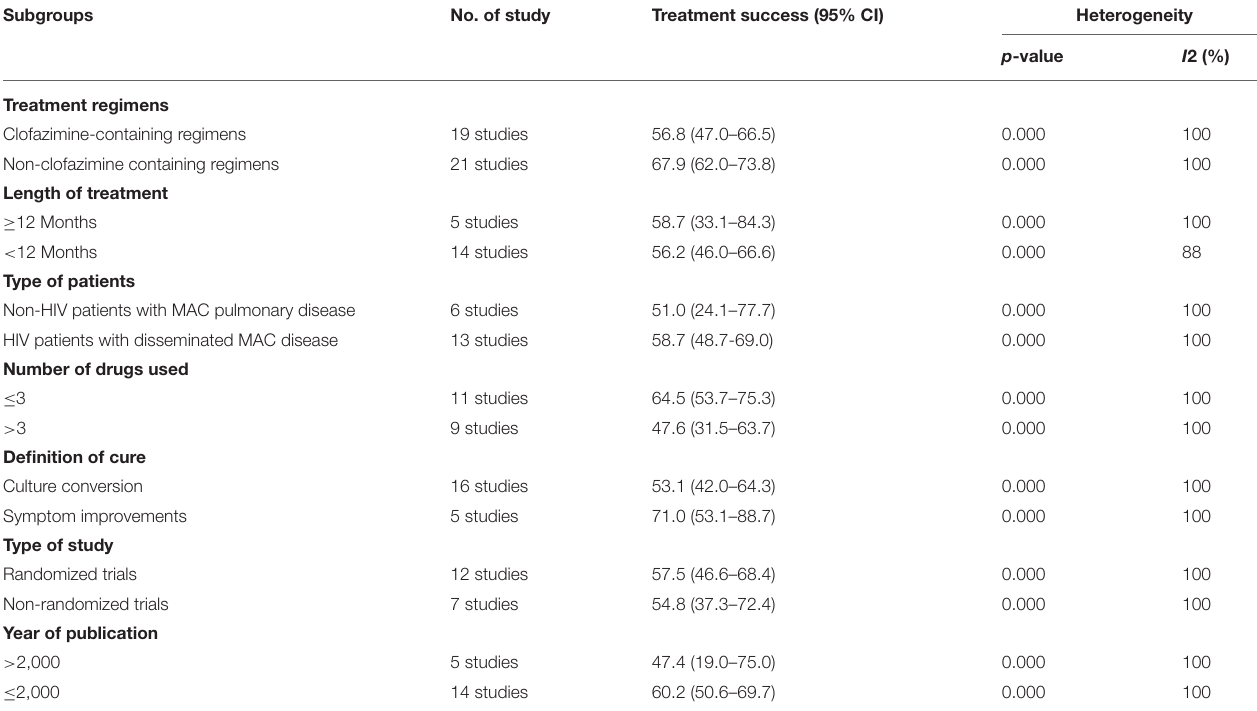
TABLE 4 | Pooled treatment success among subgroups of studies with clofazimine in their regimens. Subgroups